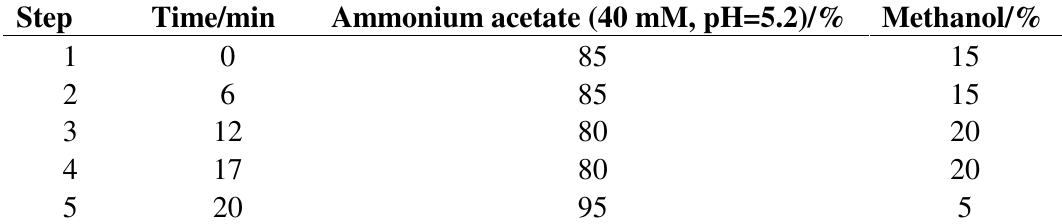
Table 6. Solvent elution program for